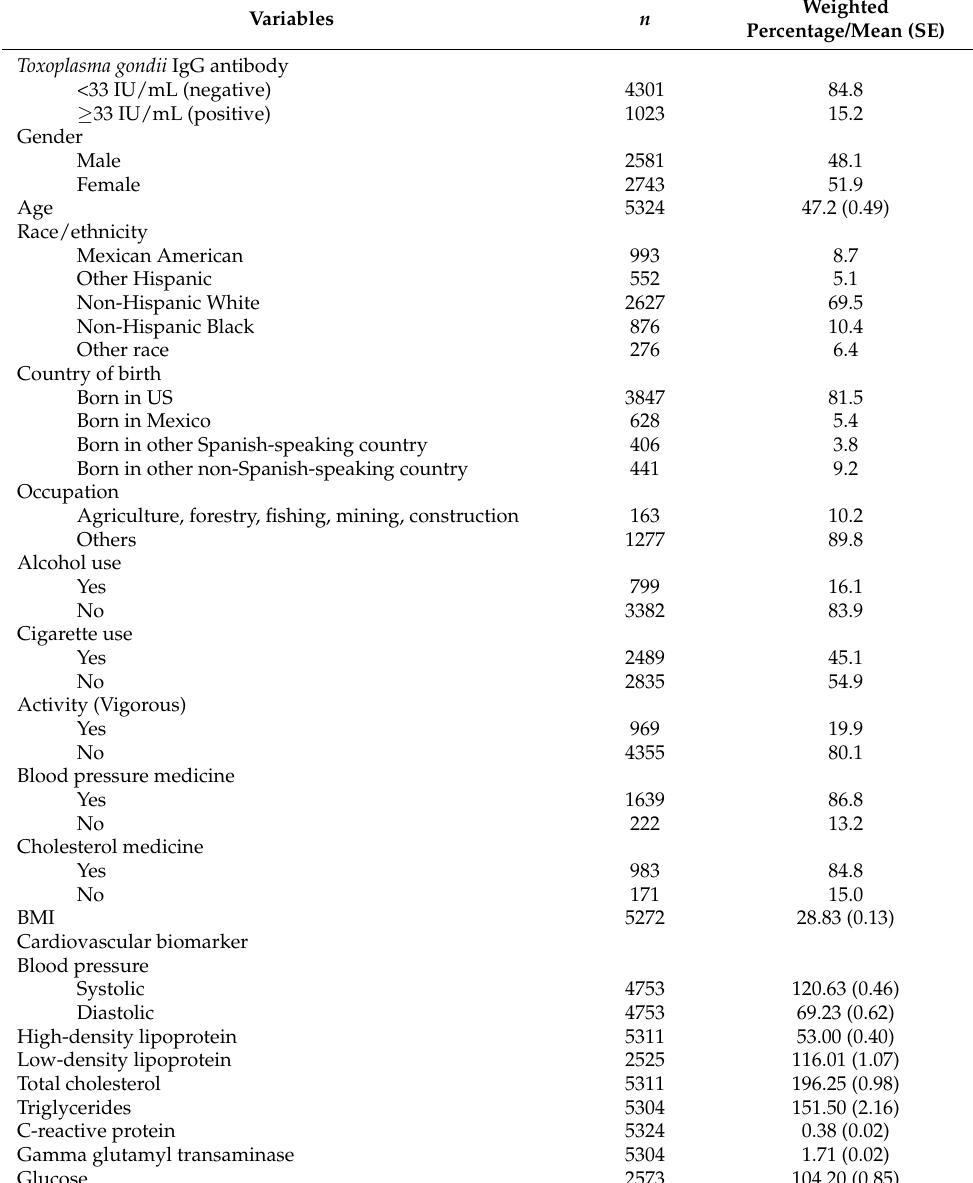
Table 2. Sampled data characteristics, NHANES 2009–2010, n =